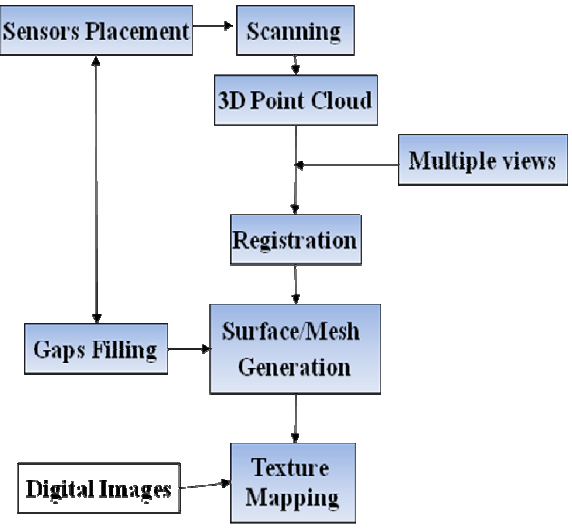
Figure 3: The employed range-based methodology for large and complex structure 3D surveying and modeling